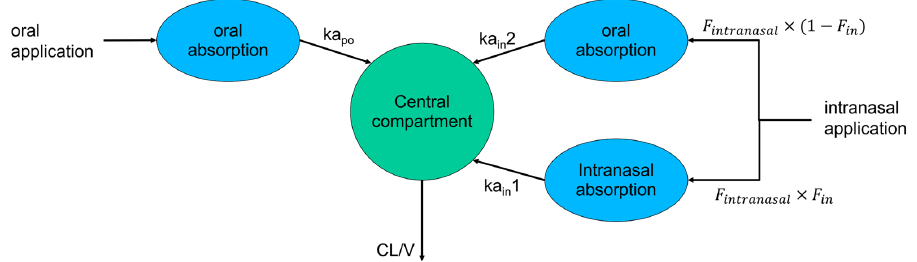
Figure A1. Schematic representation of the azelastine PK model A describing the plasma concentration-time profiles after oral and intranasal applications.